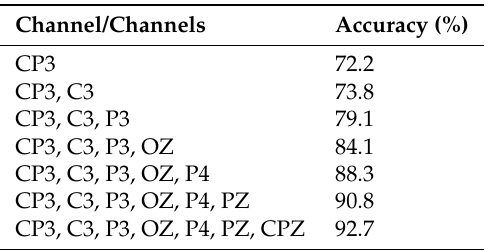
Table 5. Isolated